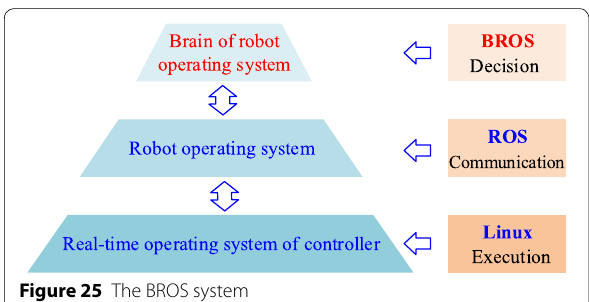
Figure 25 The BROS